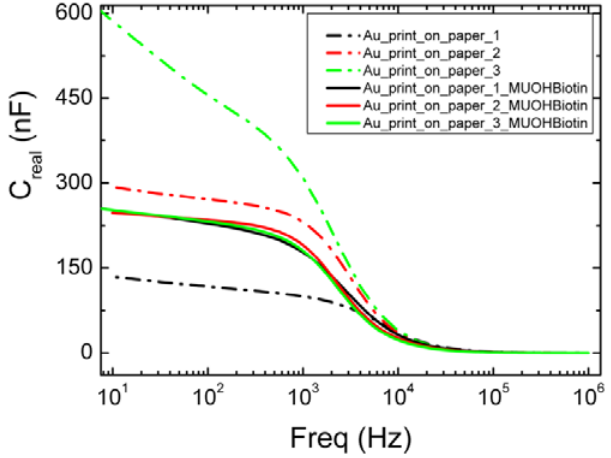
Figure 6. Capacitance as a function of frequency after application of SAM.